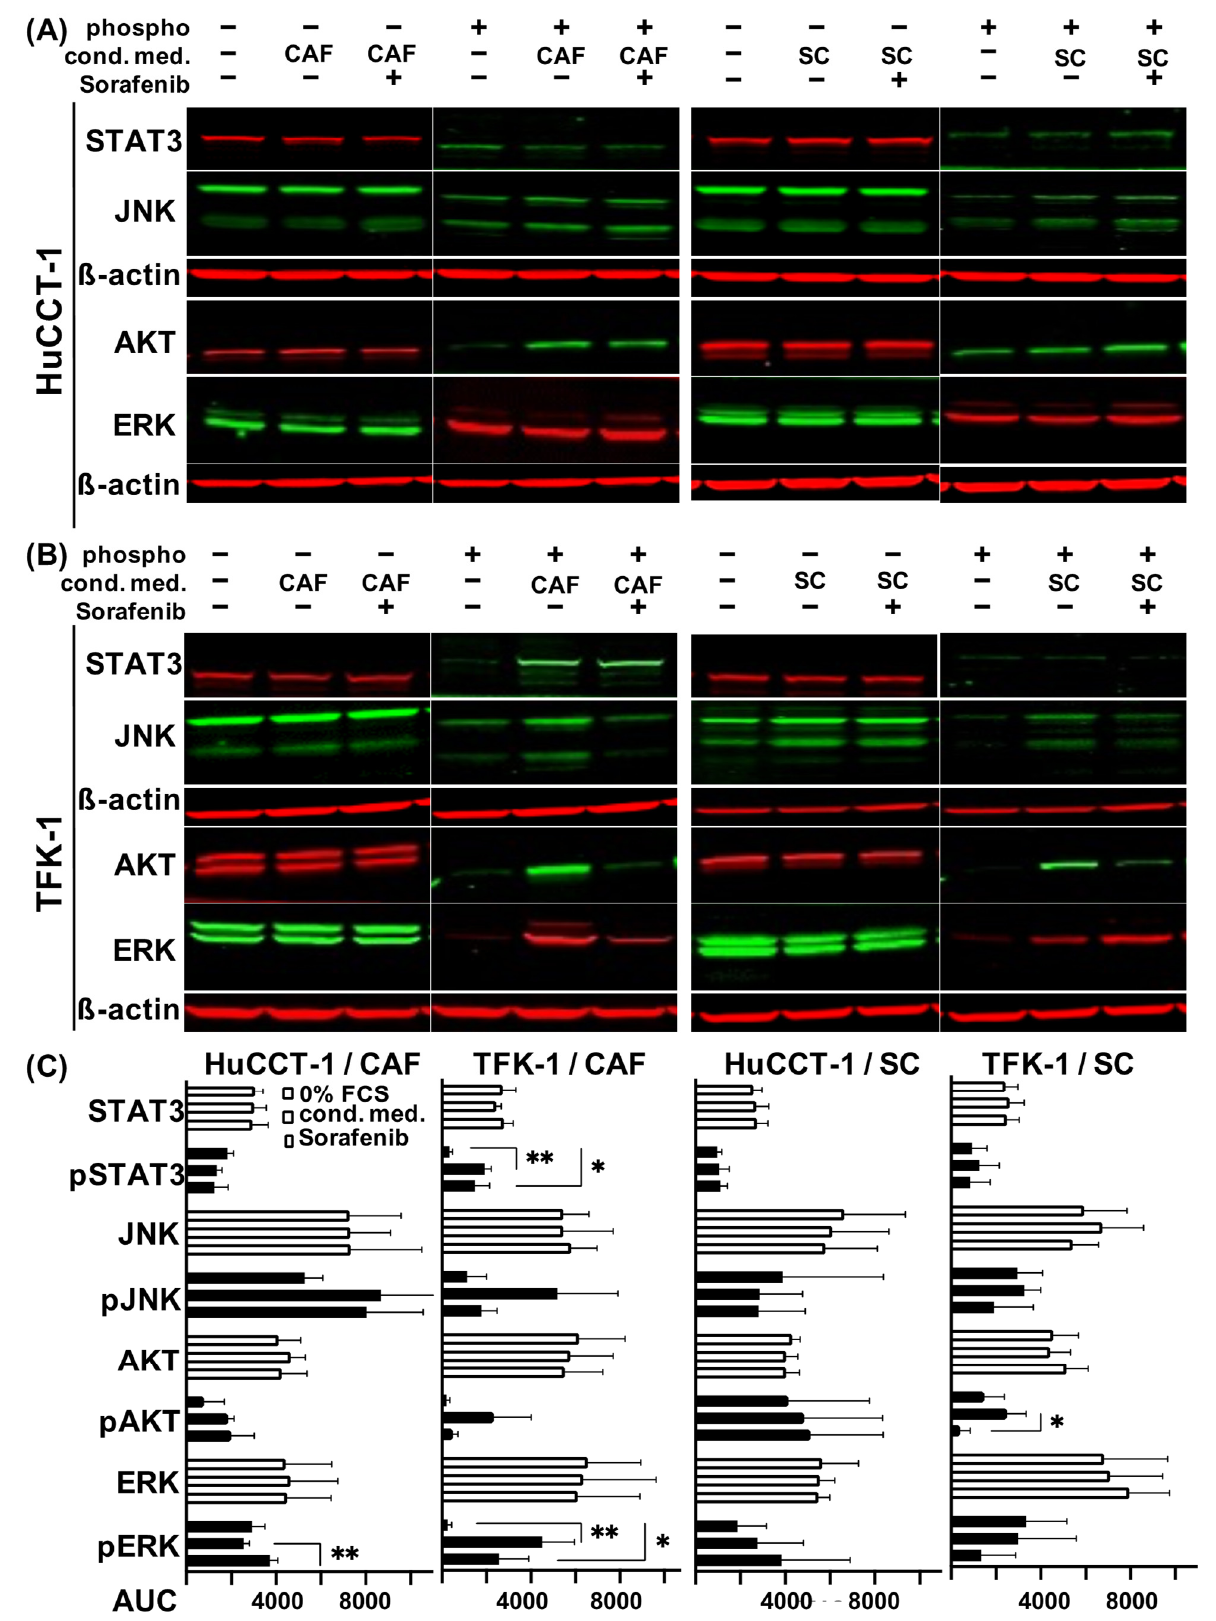
Figure 5. Impact of CAF and SC on signaling pathways in CCA cells in the absence or presence of Sorafenib. ( A ) HuCCT-1 cells and ( B ) TFK-1 cells were initially cultured in 0% FCS medium for 24